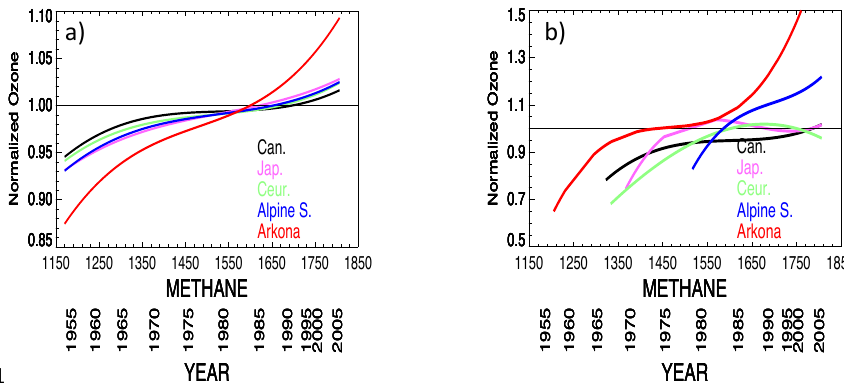
Figure 8. (a) Simulated and (b) measured cubic fits of normalized ozone vs. global surface methane concentration for various long-term tropospheric measurement sites: the regional average of the Canadian (Can.), central European (Ceur.) and Japanese (Jap.) ozonesonde sites at 500hPa, the average of the Jungfraujoch and Zugspitze sites (Alpine S.) and the Arkona surface site. Ozone is normalized by its 1980–1985 concentration at each site. Globally averaged methane is from the WACCM simulation. The year corresponding to the methane concentration is given. Simulated ozone is the ensemble